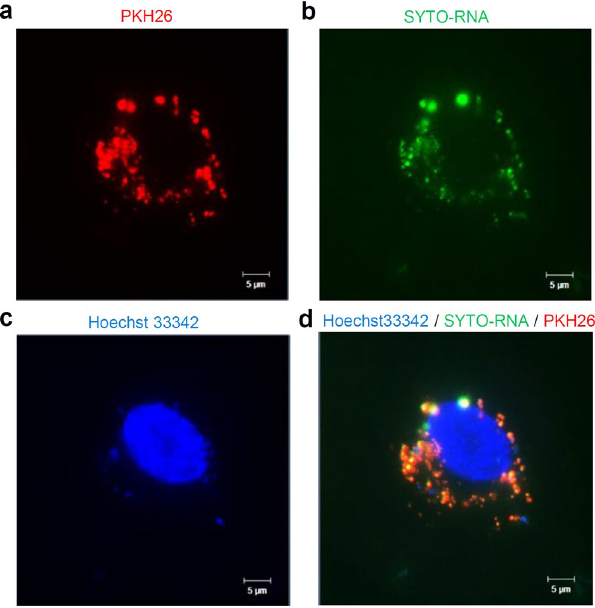
Figure 5. The labeling of HepG2-exosomes and RNAs in HUVECs. ( a ) The PKH26 labeled HepG2-exosomes incorporated in HUVECs. ( b ) The RNAs and miRNAs labeled with SYTO-RNASelect in HUVECs. ( c ) The nuclear of HUVECs labeled with Hoechst33342. ( d ) The merge image of HepG2-exosomes labeled with PKH26 and RNAs and miRNAs labeled with SYTO-RNASelect in